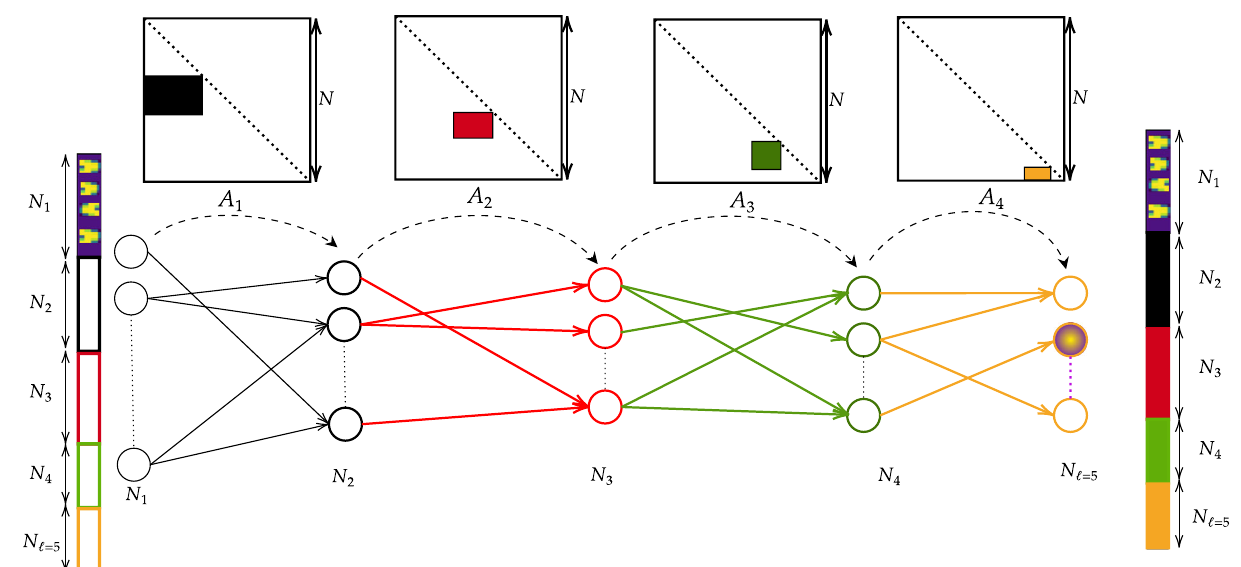
Fig. 3 The non-linear setting. The non-linear version of the training scheme returns a multilayered architecture with self-loops links in direct space. Linear and non-linear transformation can be combined at will, matrices A k providing the connection between successive layers. Linear layers can be retracted in operational mode, following a straightforward variant of the compacti fi cation procedure described in the main body of the paper.